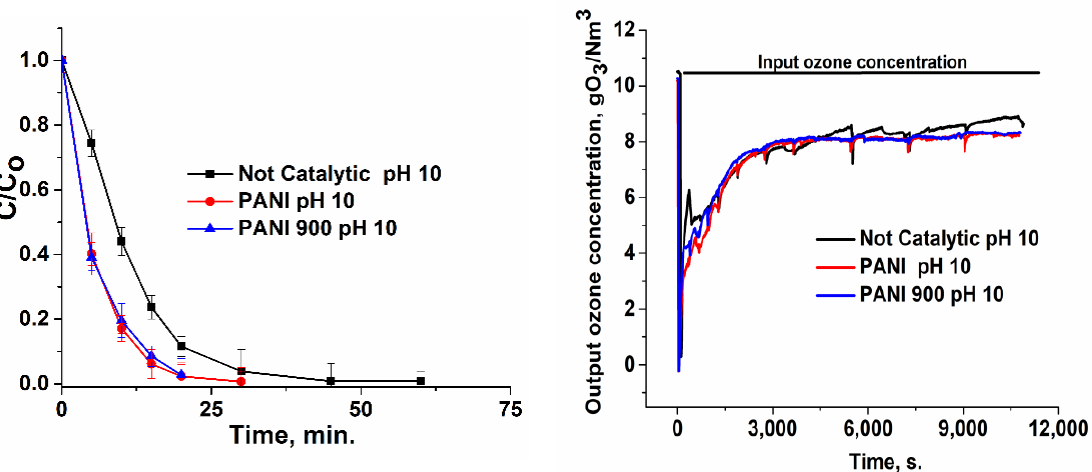
Figure 9. Variation in the normalized ibuprofen concentration and ozone concentration for the cat- alytic process at pH = 7.